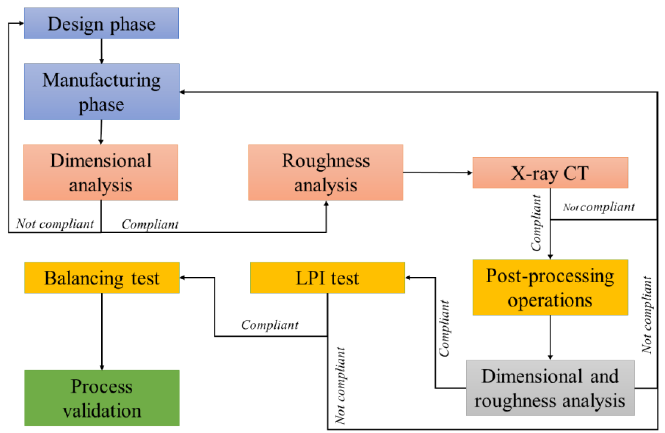
Figure 2. Verification plan — flow chart.